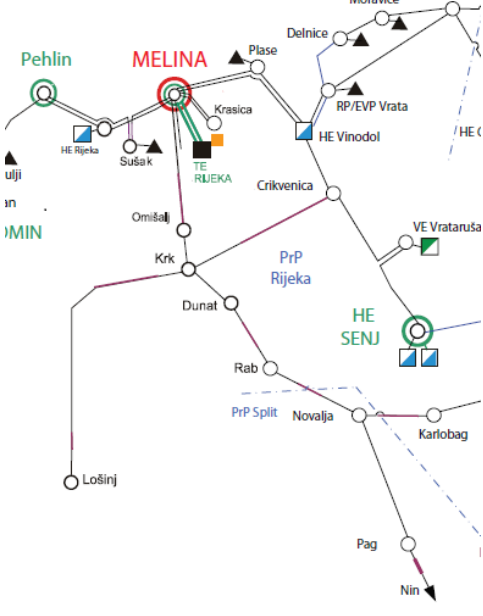
Figure 2. Electrical representation of the observed